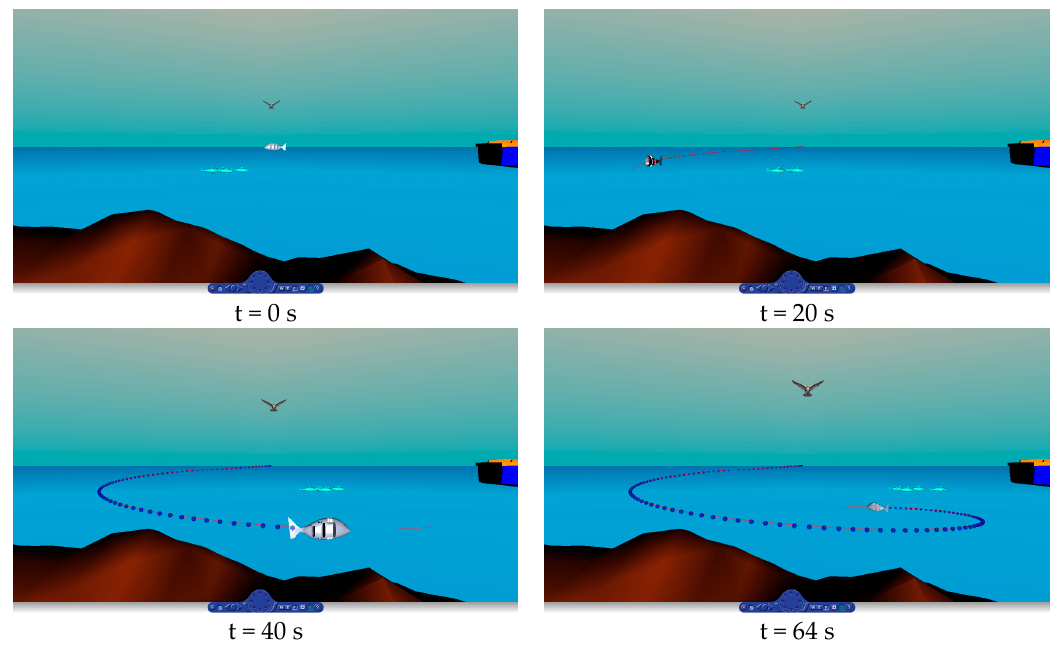
Figure 26. Isometric view of the underwater environment for closed loop P 2 tracking.